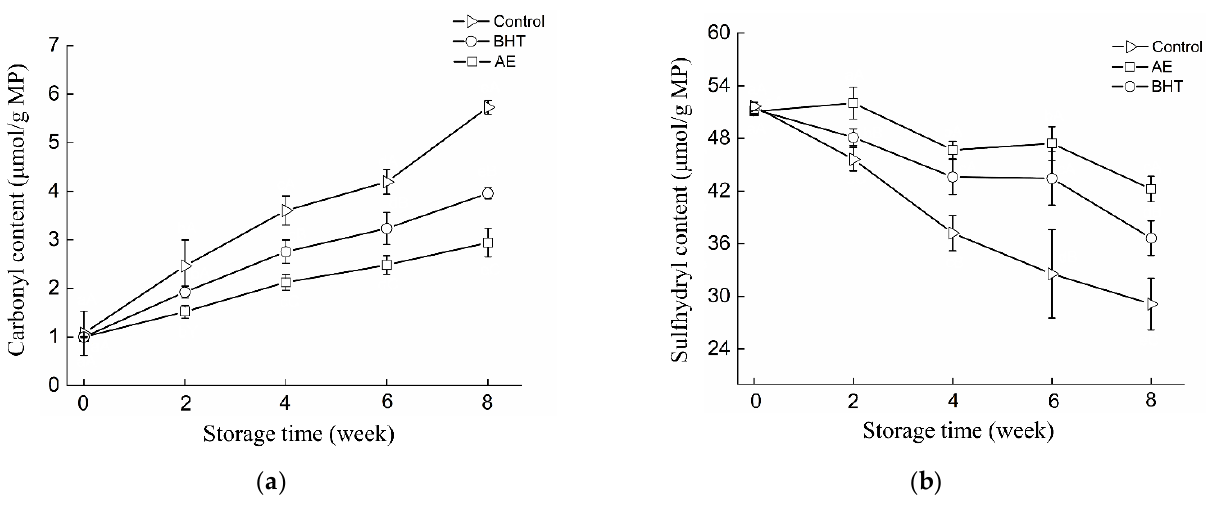
Figure 2. Changes in carbonyls’ contents ( a ) and sulfhydryl contents ( b ) of shrimp surimi products treated with AE, BHT, and control during frozen storage.